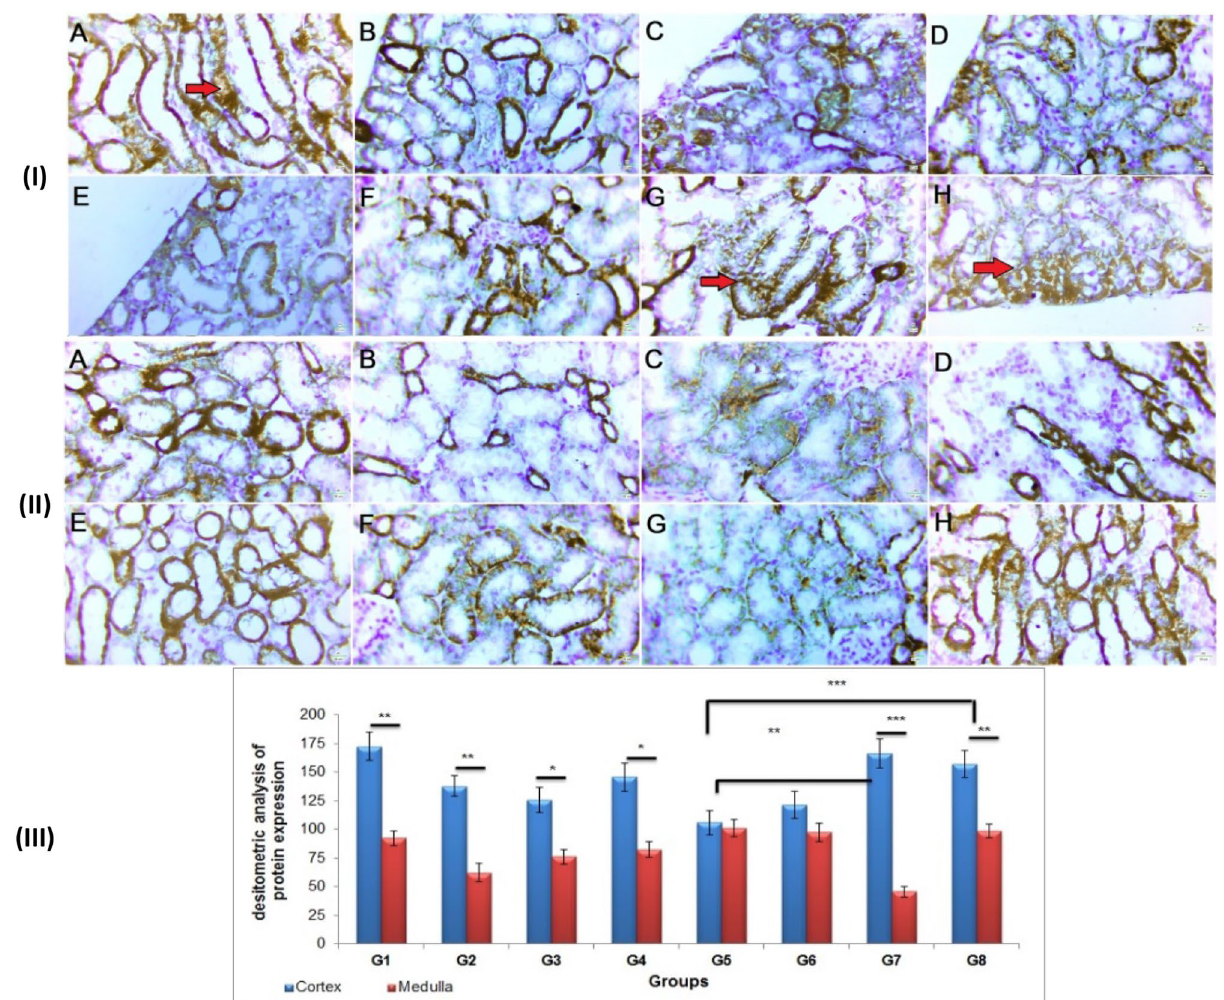
Figure 9. The effect of different treatments on Na + /K + -ATPase immunoreactivity and densitometry in CDDP- induced nephrotoxicity in all the studied groups. ( I ) a micrograph of a section of the kidney showing Na + /K + - ATPase immunoreactivity in the cortex. ( II ) a micrograph of a section of the kidney showing Na + /K + -ATPase immunoreactivity in the medulla. ( III ) Na + /K + -ATPase densitometry immunohistochemistry protein expression analysis in both cortex and medulla. Micrographs of the kidney section of ( A ) the control group, ( B ) the GA group, ( C ) the CMCS group, ( D ) the GA@CMCS group, ( E ) the CDDP group, ( F ) the (CDDP + GA) group, ( G ) the (CDDP + CMCS) group, and ( H ) the (CDDP + GA@CMCS) group. (Na + /K + -ATPase expression, scale bar: 50 μm). All data have been presented as mean ± SE. *p < 0.05, **p < 0.01, and ***p <